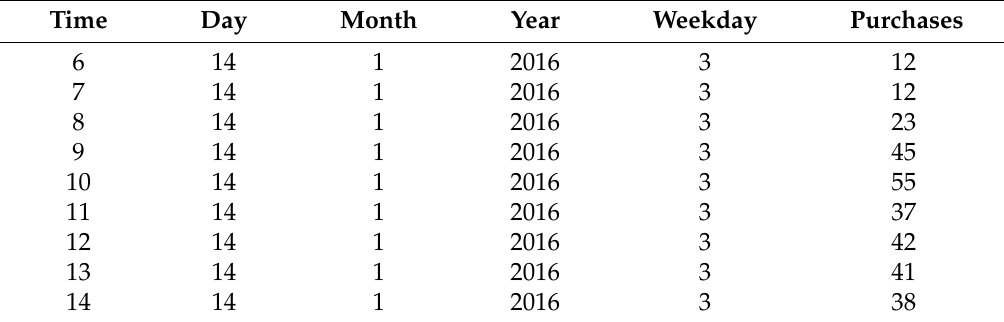
Table 2. Sample training dataset.